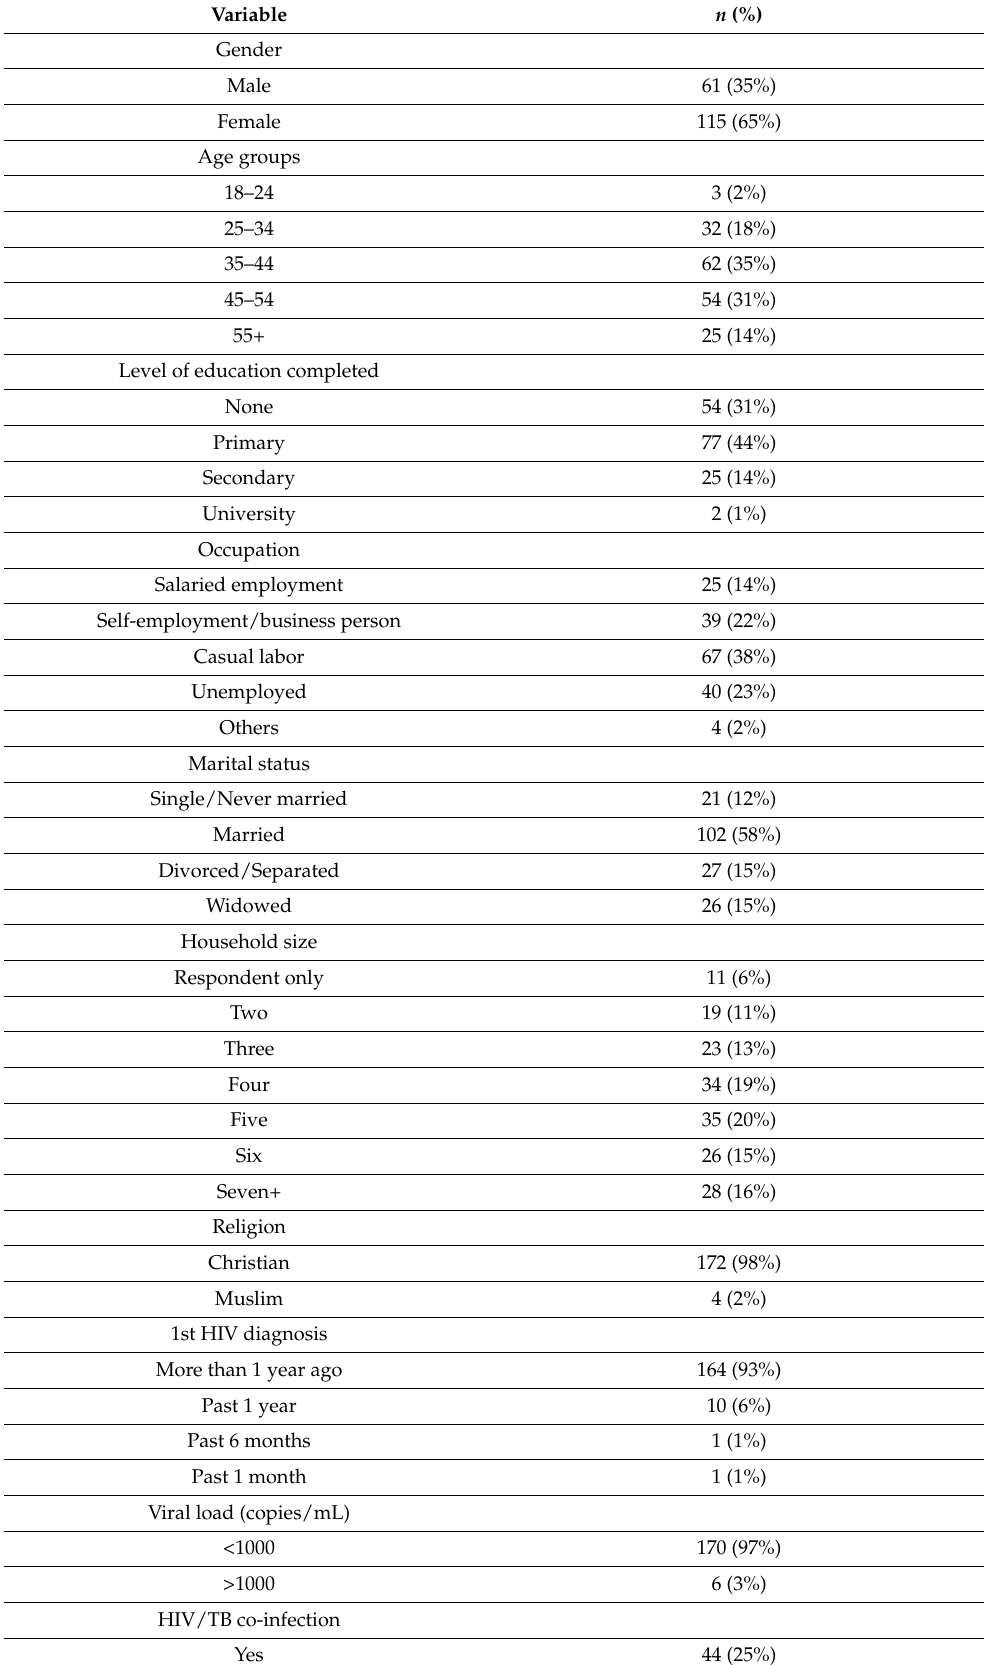
Table 2. Demographic and clinical